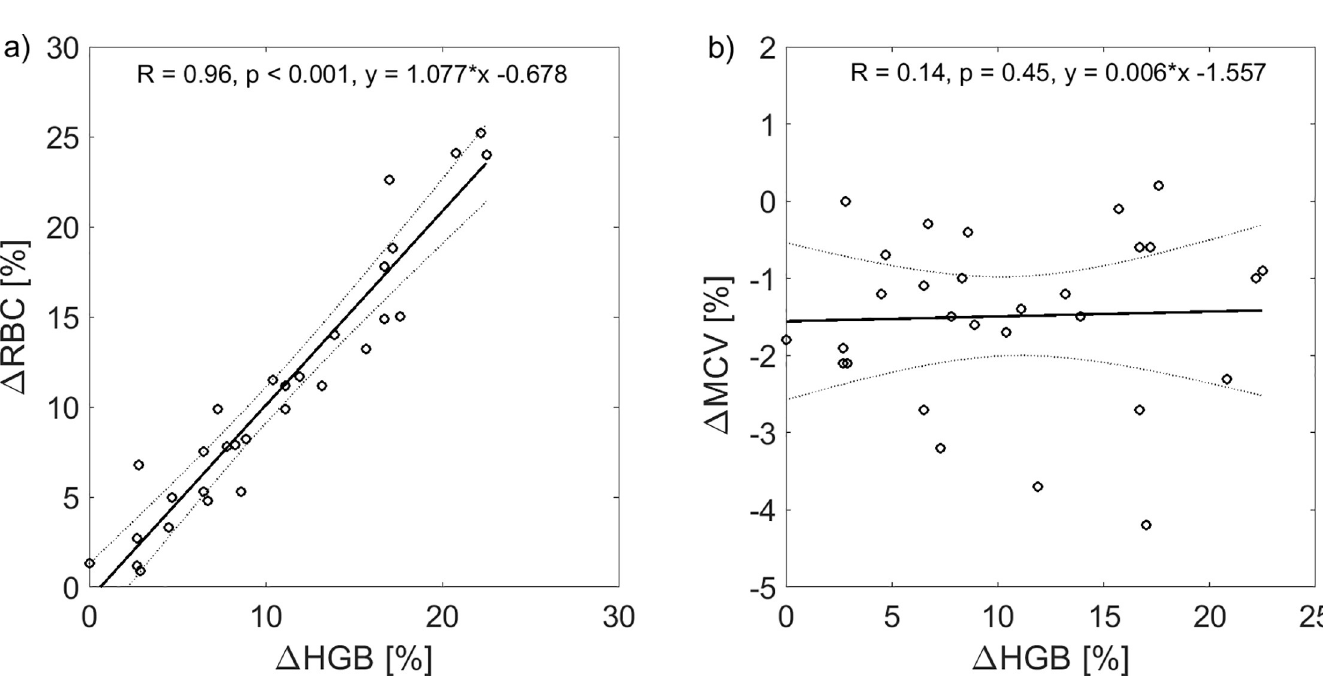
Fig 4. Correlation between dialysis-induced changes in red blood cell count, hemoglobin and mean corpuscular red cell volume. Relative changes of hemoglobin ( Δ HGB) paired with a) relative changes of red blood cell count ( Δ RBC) and b) relative changes of mean corpuscular red cell volume ( Δ MCV) during all analyzed hemodialysis sessions with linear regression fit (solid lines) and 95% confidence bounds (dotted lines).